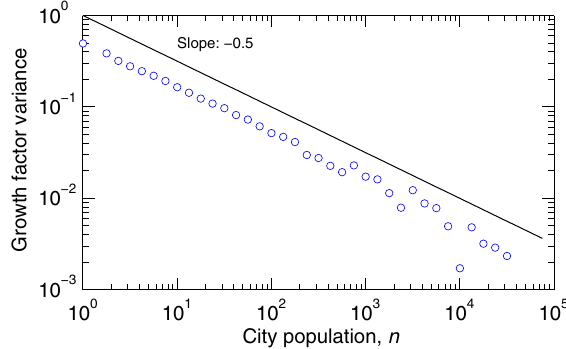
FIG. 4 (color online). Growth factor variance by population size, for M ¼ 225 . The solid line represents a slope of − 1 = 2 , which is expected from the theory for the b=a → 0